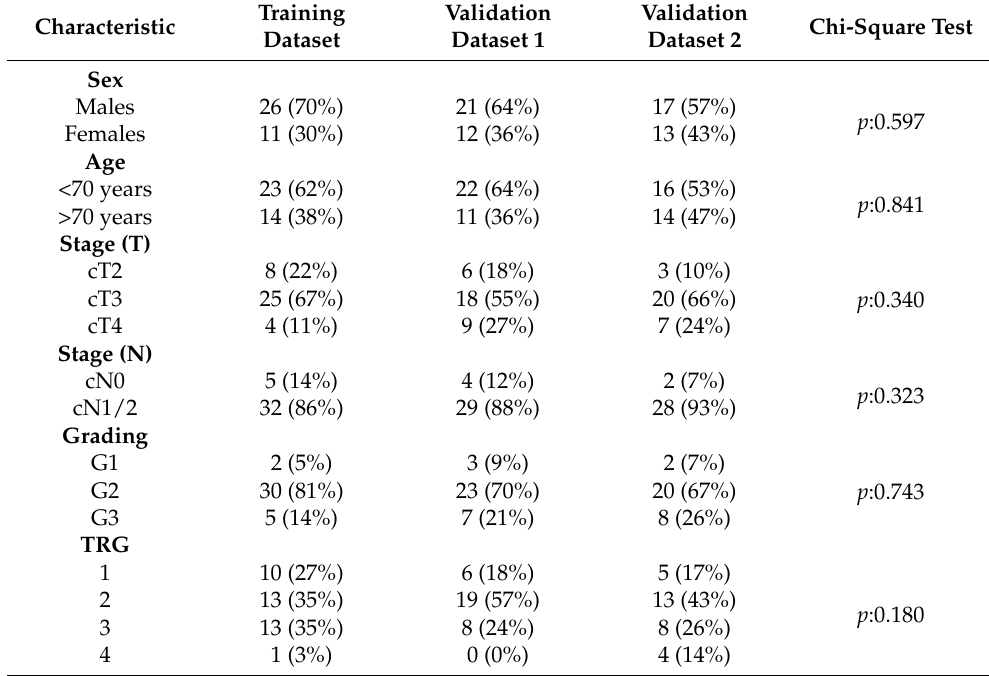
Table 2. Characteristics of